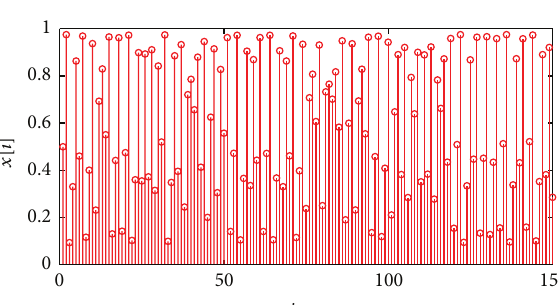
Figure 12: 125Hz sine wave message. Blue: sent message. Yellow: encrypted key.